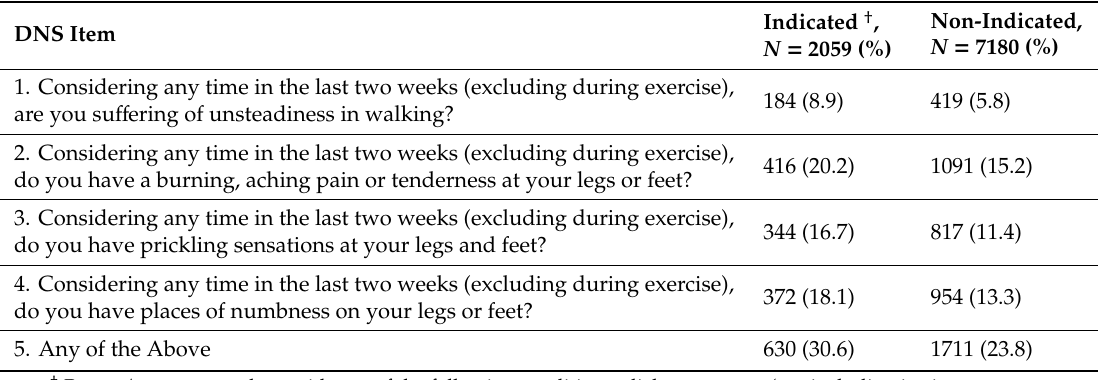
Table 2. The Diabetic Neuropathy Symptom (DNS) score prevalence among the Indicated and Non-Indicated peripheral neuropathy